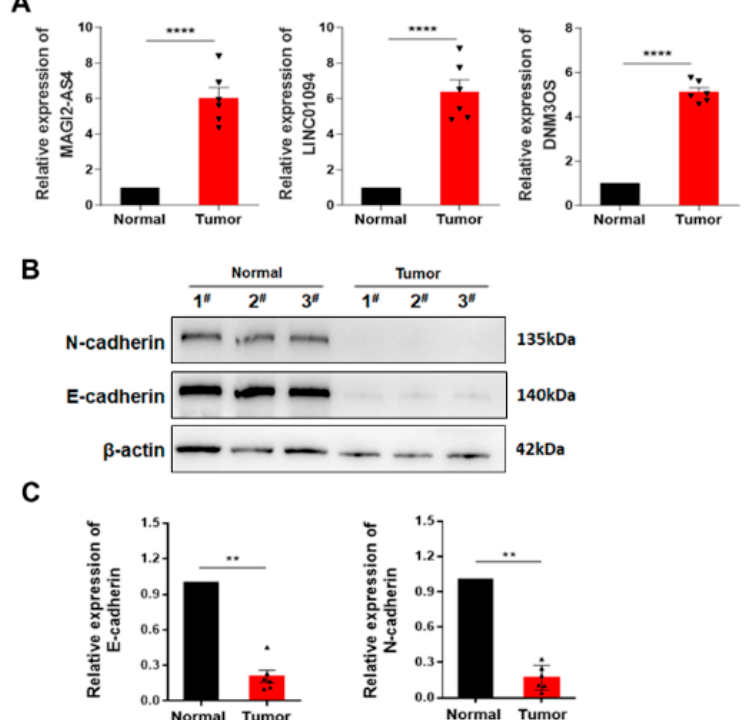
Figure 9. Validation of three EMT-associated lncRNAs in a patient tumor. ( A ) Relative mRNA levels of lncRNA DNM3OS, MAGI2-AS3 and LINC01094 in patient tumor tissues. ( B , C ) Western blot analysis of N-cadherin and E-cadherin in human tumor tissues. Ns; p > 0.05; ** p < 0.01, **** p < 0.0001.4. Discussion.